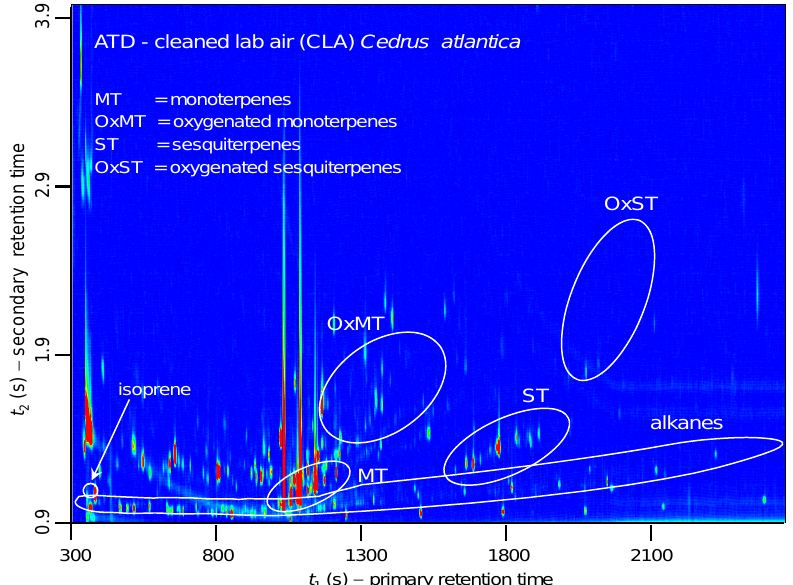
Fig. 6. GC × GC-TOFMS chromatogram of VBOCs from Cedrus atlantica by ATD using cleaned laboratory air (CLA); obtained using the “improved” chromatographic conditions (Table